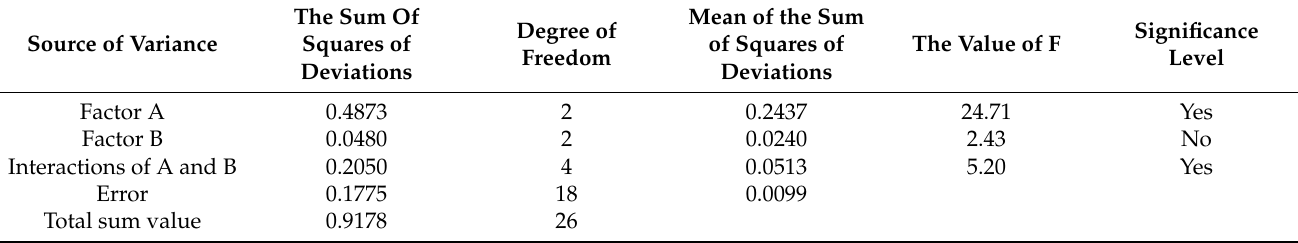
Table 12. Analysis of variance of adhesion strength test of frozen ice on aluminum alloy surface.